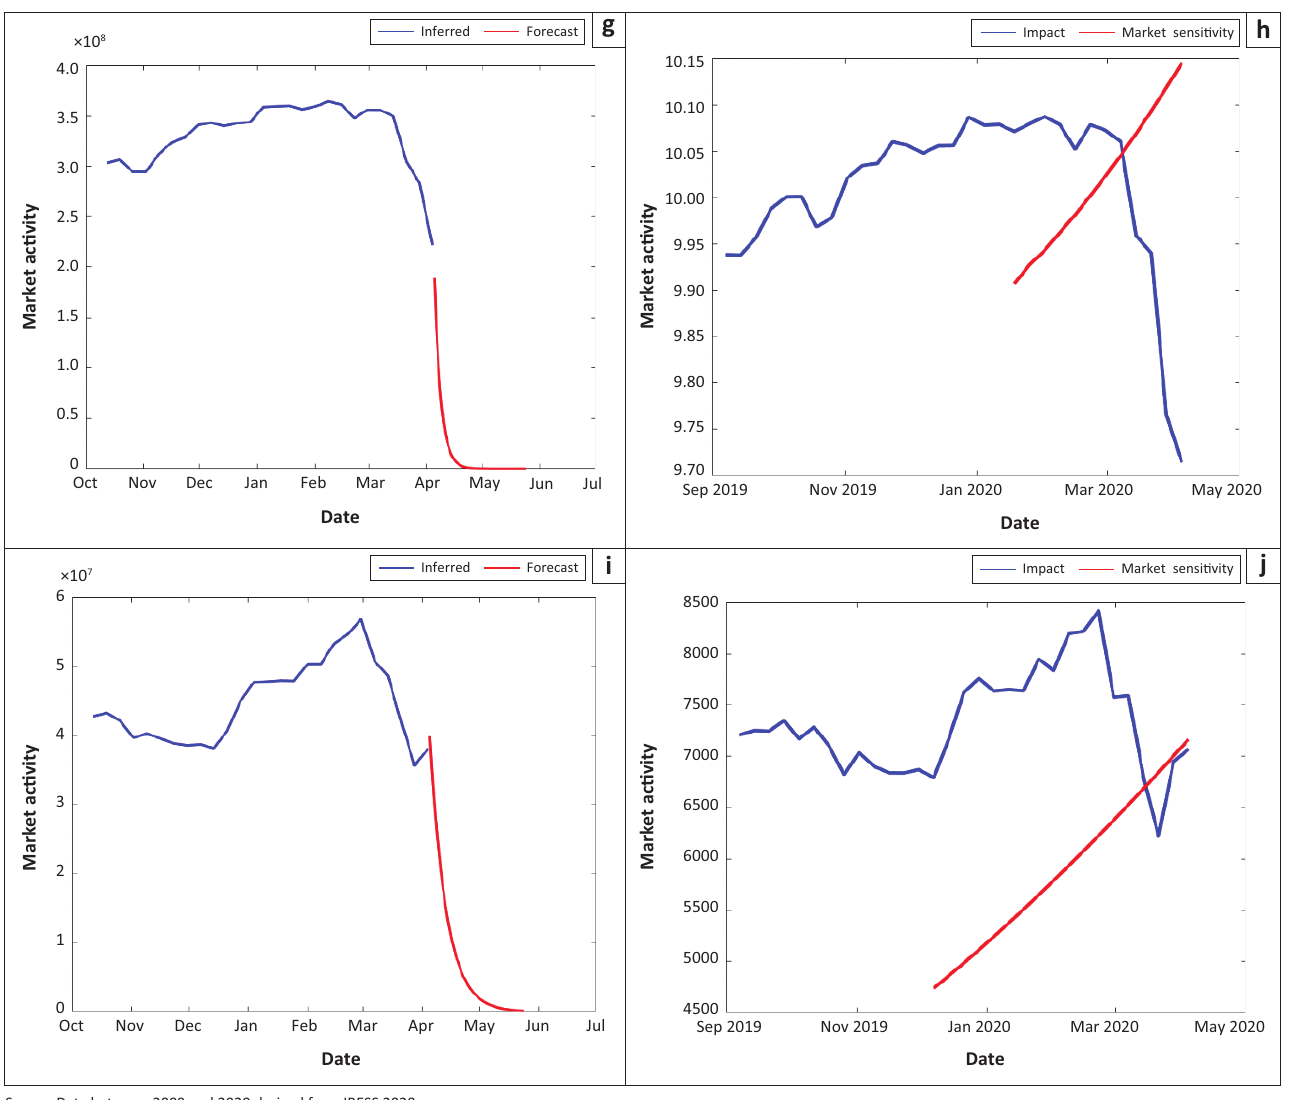
FIGURE 2 (Continues ... ): Graphical representation of the Dax, Dow Jones Industrial Average, Financial Times Stock Exchange/Johannesburg Stock Exchange All Share, Nikkei 225 and the London Stock Exchange highlighting in column 1 the ‘Inferred’ and ‘Forecasted Impact’ using a generalised autoregressive conditional heteroscedasticity model. An autoregressive integrated moving average model is applied in column 2, highlighting the ‘Sensitivity’ and ‘Impact’ of COVID-19 on the respective stock market indices. (a) Impact of conditional variances on the Dax, (b) Dax impact covid 19, (c) Impact of conditional variances on Dow Jones, (d) Dow impact covid 19, (e) Impact of conditional variances model on FTSE, (f) FTSE impact covid 19, (g) Impact of conditional variances on the Nikkei, (h) Nikkei 225 impact covid 19, (i) Impact of conditional variances on the LSE, (j) London stock exchange impact covid